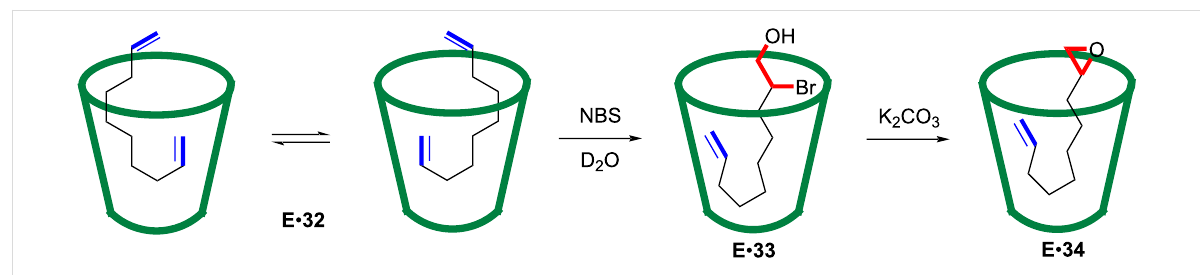
Figure 10: Site-selective monoepoxidation of α , ω -dienes mediated by the water-soluble cavitand host E .